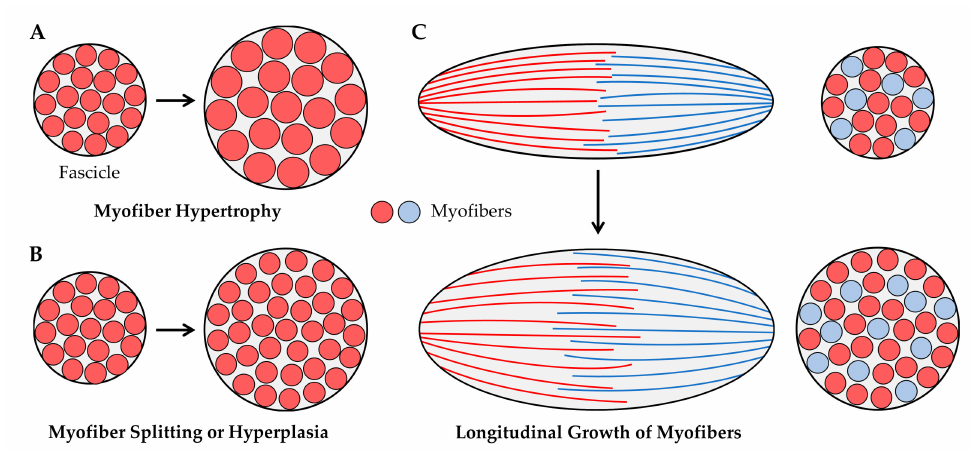
Figure 4. Illustration of how the radial growth of muscles fascicles could result from ( A ) myofiber hypertrophy, ( B ) myofiber splitting or hyperplasia, or ( C ) longitudinal growth of myofibers that exhibit intrafascicular terminations, such as those observed in the long sartorius and gracilis muscles of humans